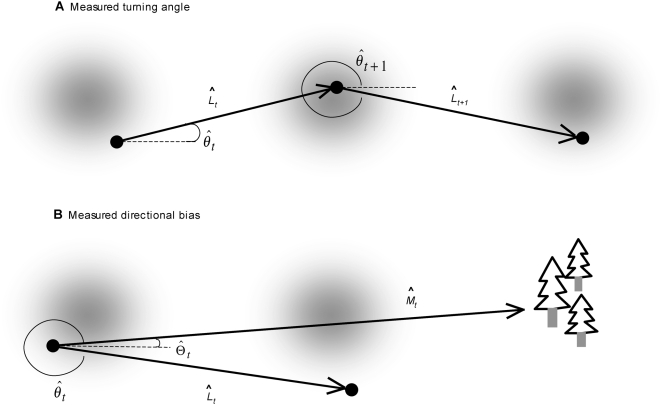
Location error can greatly affect (A) measured turning angles and (B) directional biases.The grey circles denote the probability density of measured locations for a moving animal. These are centered around the animal's true location. The solid black dots are measured locations. (A) The animal's true turning angle is zero, but the measured turning angle, , is approximately 45°. (B) The animal is moving towards the trees (true directional bias is 0°), however, because of measurement error in the animal's two measured locations the measured directional bias, , is approximately 315°.